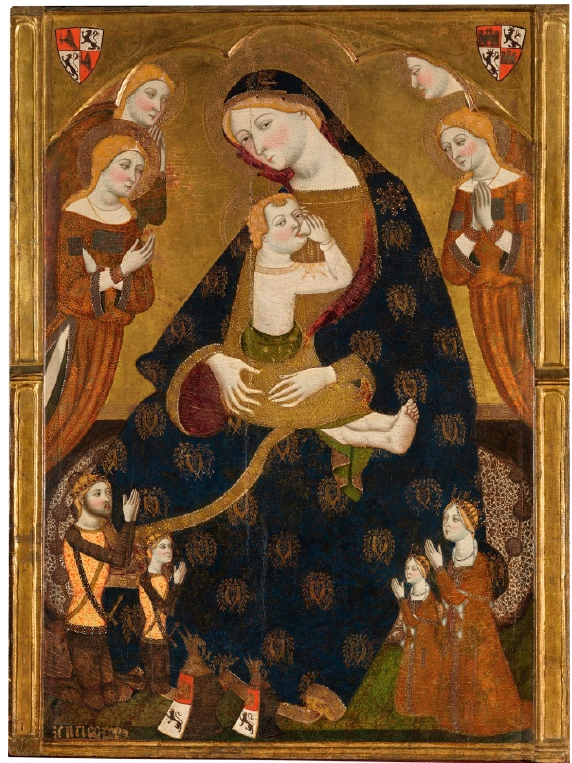
Figure 8. The Virgin of Tobed with the donors Henry II of Castile, his wife Joan Manuel, and two of their children, John and Joan (?). Madrid, Prado (P008117). Used by permission.